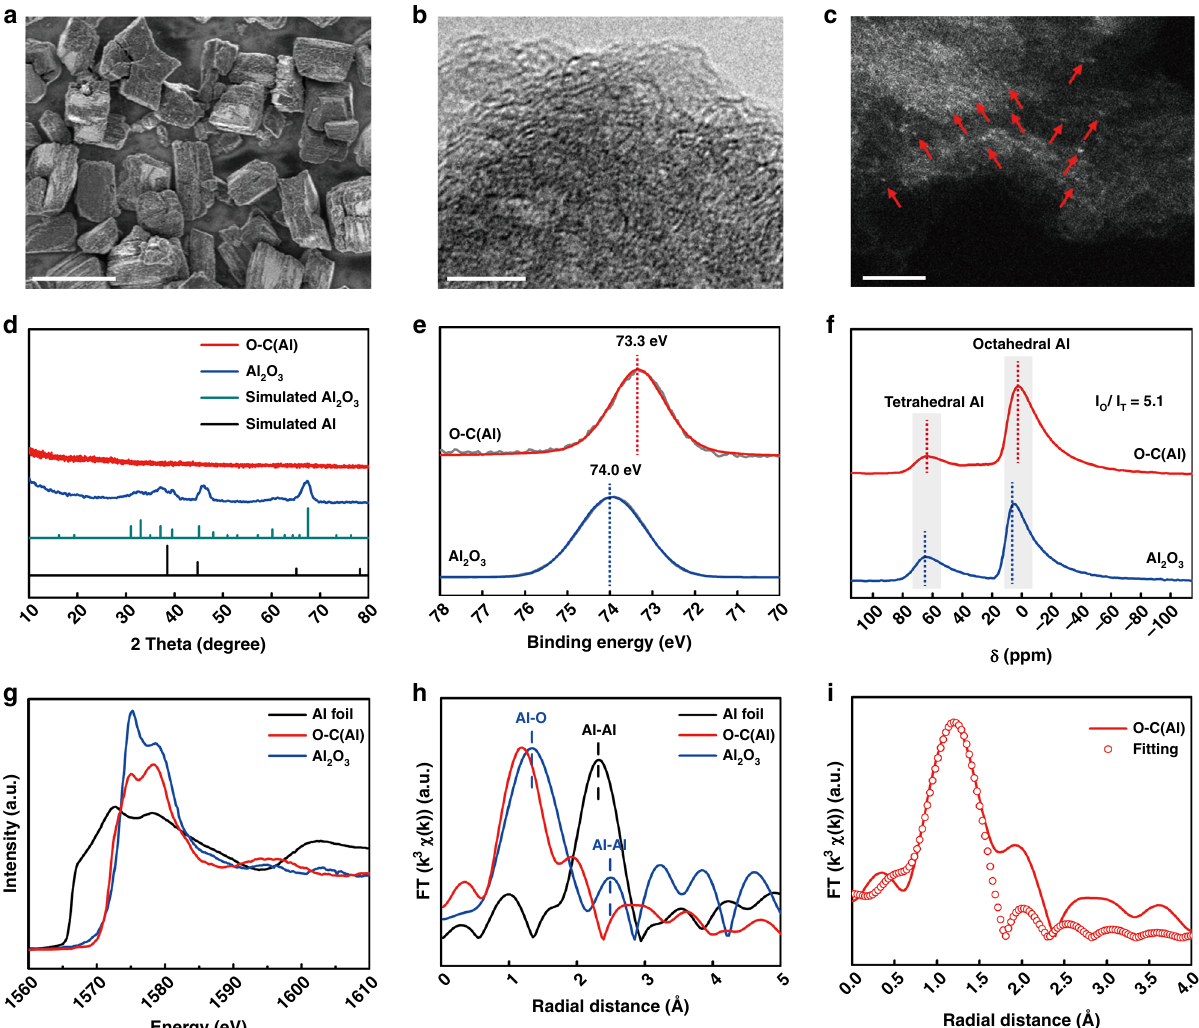
Fig. 2 Synthesis and structural characterization of O – C(M). a SEM image of O – C(Al), scale bar is 5 μ m. High-resolution TEM ( b ) and aberration- corrected HAADF-STEM ( c ) images of O – C(Al), scale bars are 5 and 2 nm, respectively. d Powder XRD patterns for simulated Al and Al 2 O 3 , as- synthesized O – C(Al) and commercial Al 2 O 3 . e High-resolution XPS spectra of Al 2p in O – C(Al) and Al 2 O 3 . f Al solid-state NMR patterns of O – C(Al)